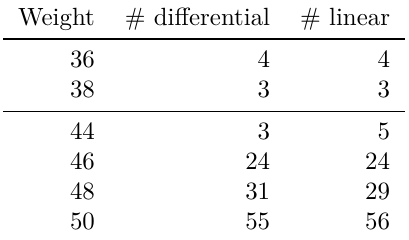
Table 6: The 3-round trail cores. The number of trail cores is up to translations along x and z , see Section 5.5.